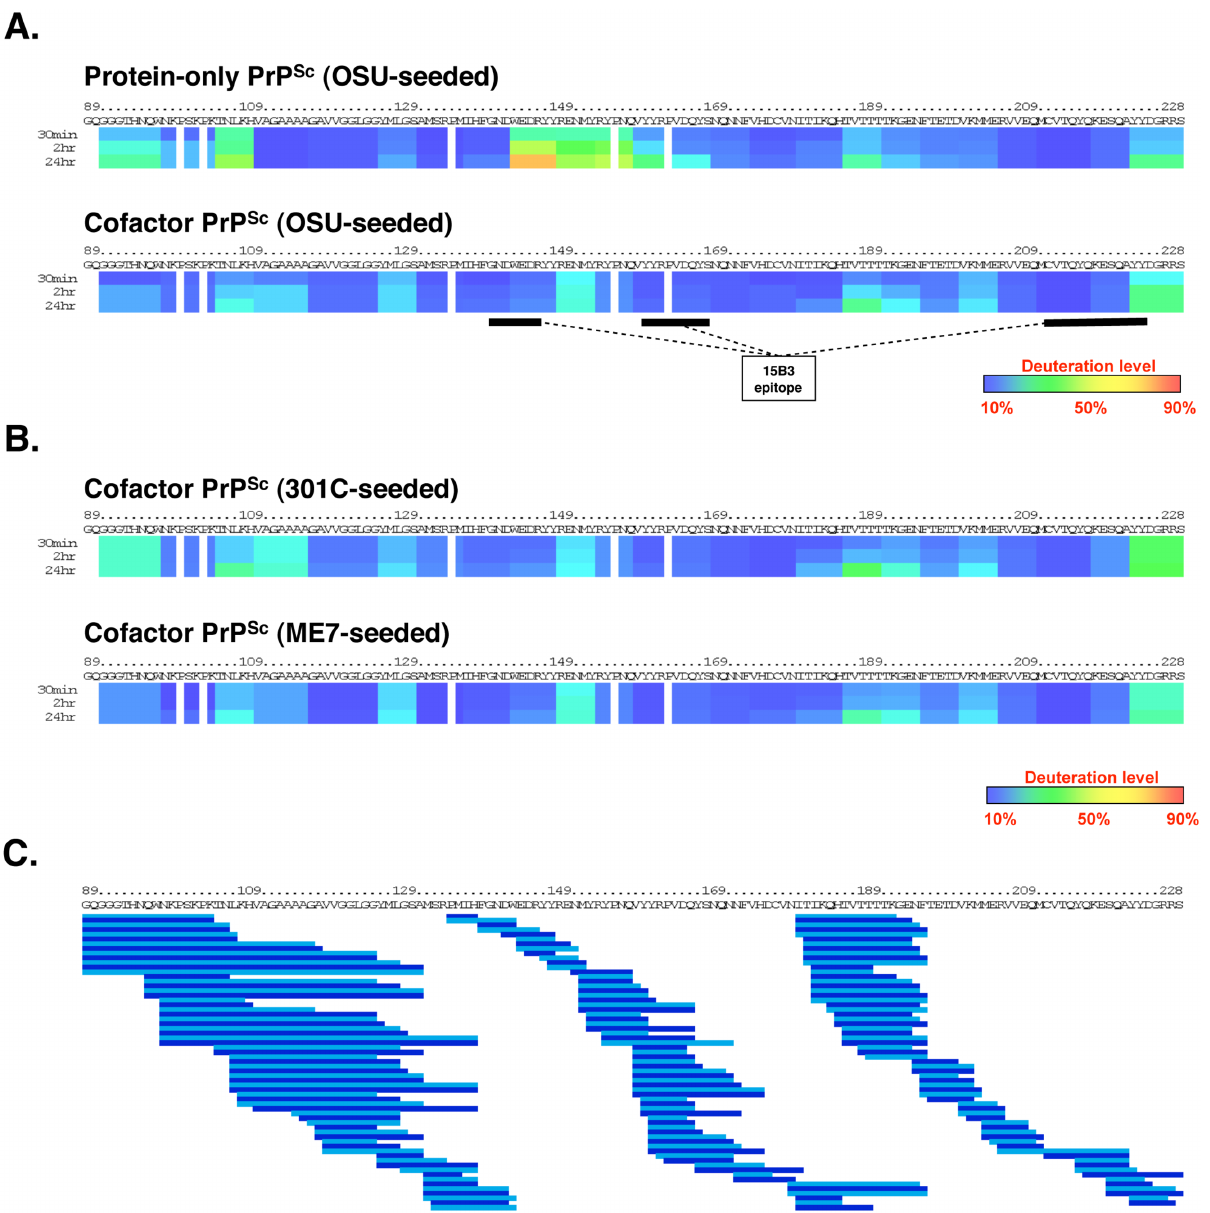
Fig 2. Regional solvent accessibility of cofactor and protein-only PrP Sc conformers. Purified PrP Sc conformers were incubated in D 2 O-containing exchange buffer for 30 min, 2 h, or 24 h and the reaction products were quenched and subjected to LC/MS to measure peptide-specific deuterium incorporation. Data from overlapping peptides was used to quantify localized deuterium exchange and construct ribbon diagrams from a representative experiment. ( A ) Regional solvent accessibility comparison between cofactor and protein-only PrP Sc conformers derived from the same OSU prion strain. The discontinuous epitope of mAb 15B3, which selectively binds infectious PrP Sc , is indicated with black bars [18]. ( B ) Regional solvent accessibility of two additional cofactor PrP Sc conformers, derived from the 301C and ME7 prion strains. ( C ) Map of the 188 high quality deuterated peptides, including different peptide charge states, identified in all four PrP Sc experimental samples and used to construct ribbon diagrams in parts ( A ) and ( B ). Alternating shades of blue in part ( C ) are used to highlight neighboring peptides. Despite complete coverage of amino acids 89 – 230 by overlapping peptides, gaps exist in the ribbon diagrams shown in parts ( A ) and ( B ) for two reasons: 1. Deuterium incorporation cannot be quantified for the two N-terminal residues of a peptide as a result of rapid back exchange [19], and 2. Proline residues lack amide hydrogen atoms and therefore do not contribute to deuterium incorporation